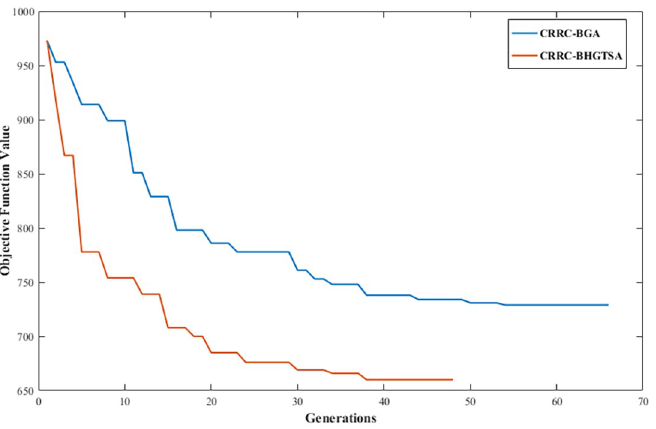
Fig 17. Convergence of the CRRC-BGA and the CRRC-BHGTSA for the 14 th experiment.